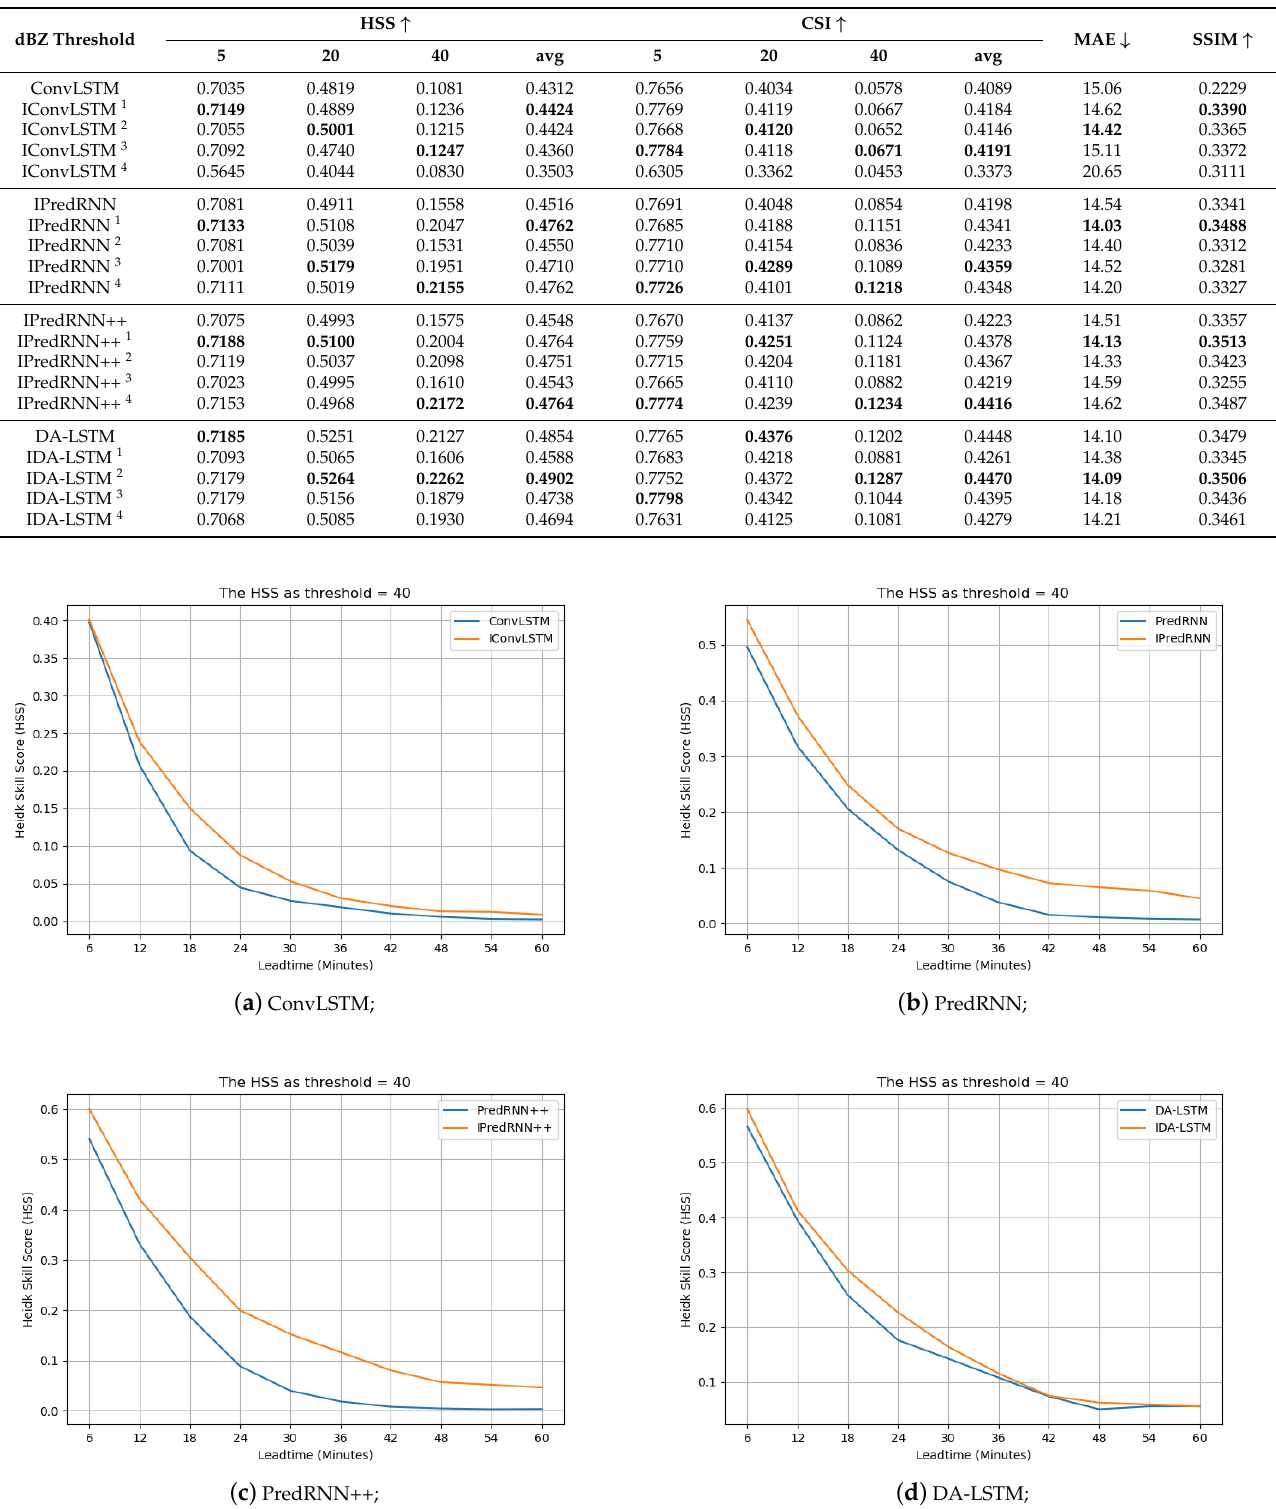
Table 3. Comparison results with the different number of interactions on the CIKM AnalytiCup 2017 competition dataset in terms of HSS and CSI. Bold denotes the best evaluate index among all models.